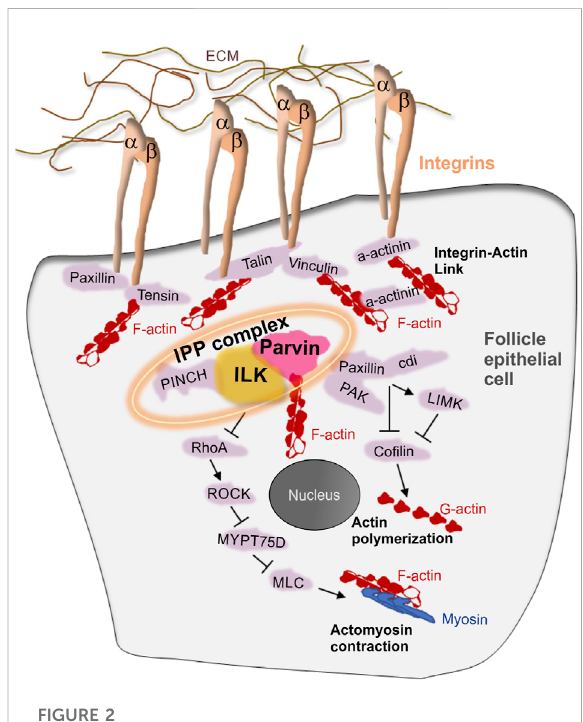
FIGURE 2 The integrin adhesome in the Drosophila follicle epithelium. Schematic representation depicting a model of integrin-associated proteins in the follicle epithelium. Several integrin adhesome proteins have been identi fi ed to express and function in the follicle cells. The tripartite IPP complex is a conserved protein complex containing Integrin-Linked Kinase (ILK), Parvin and PINCH and plays central role in the assembly and function of the integrin